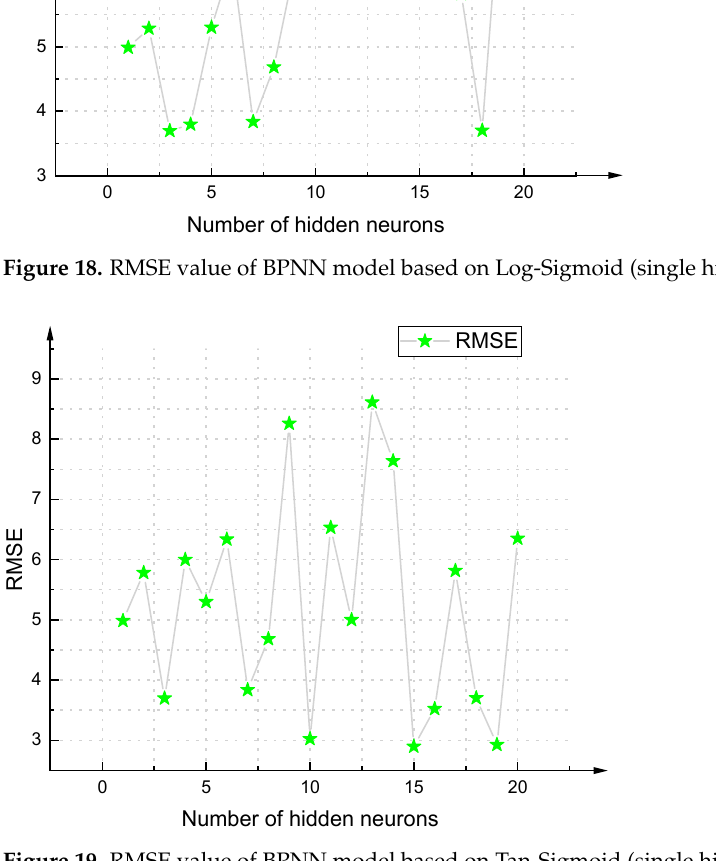
Figure 19. RMSE value of BPNN model based on Tan-Sigmoid (single hidden layer).